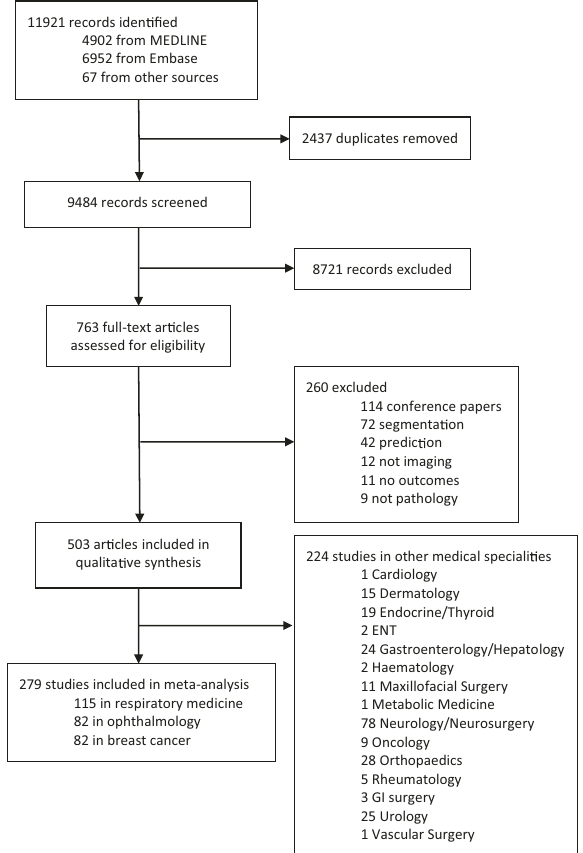
Fig. 1 PRISMA fl ow diagram of included studies. PRISMA (preferred reporting items for systematic reviews and meta-analyses) fl ow diagram of included